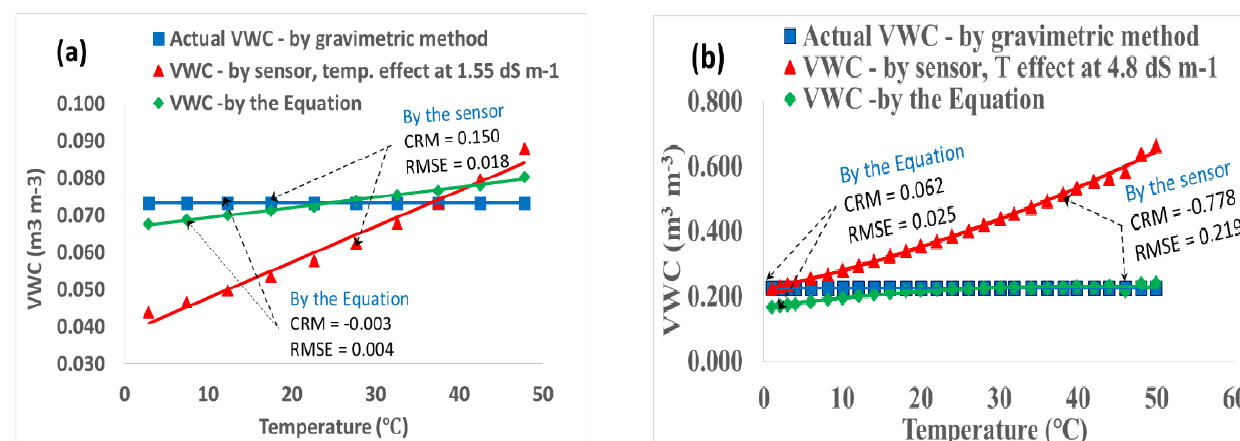
Figure 13. Comparison between VWC values measured by the sensors using gravimetric method and calculated by proposed L&O correction equation with gradually increasing soil temperature at ( a ) 1.55 dS m − 1 in low moisture and ( b ) 4.62 dS m − 1 in field-capacity moisture. Table 9. Statistical analysis of performance comparison of sensor and proposed L&O correction equation for correcting gradual increase in salinity and temperature on sensor readings as deter- mined by RMSE, RMSE, and CRM in field capacity and saturated point moisture.